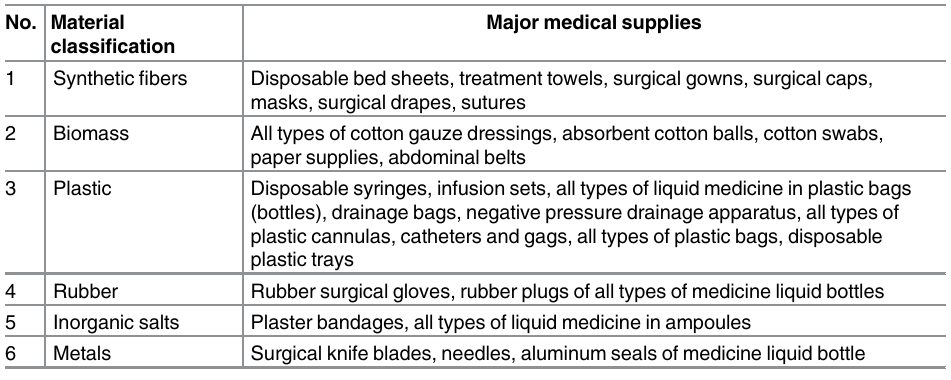
Table 3. Medical waste classification by